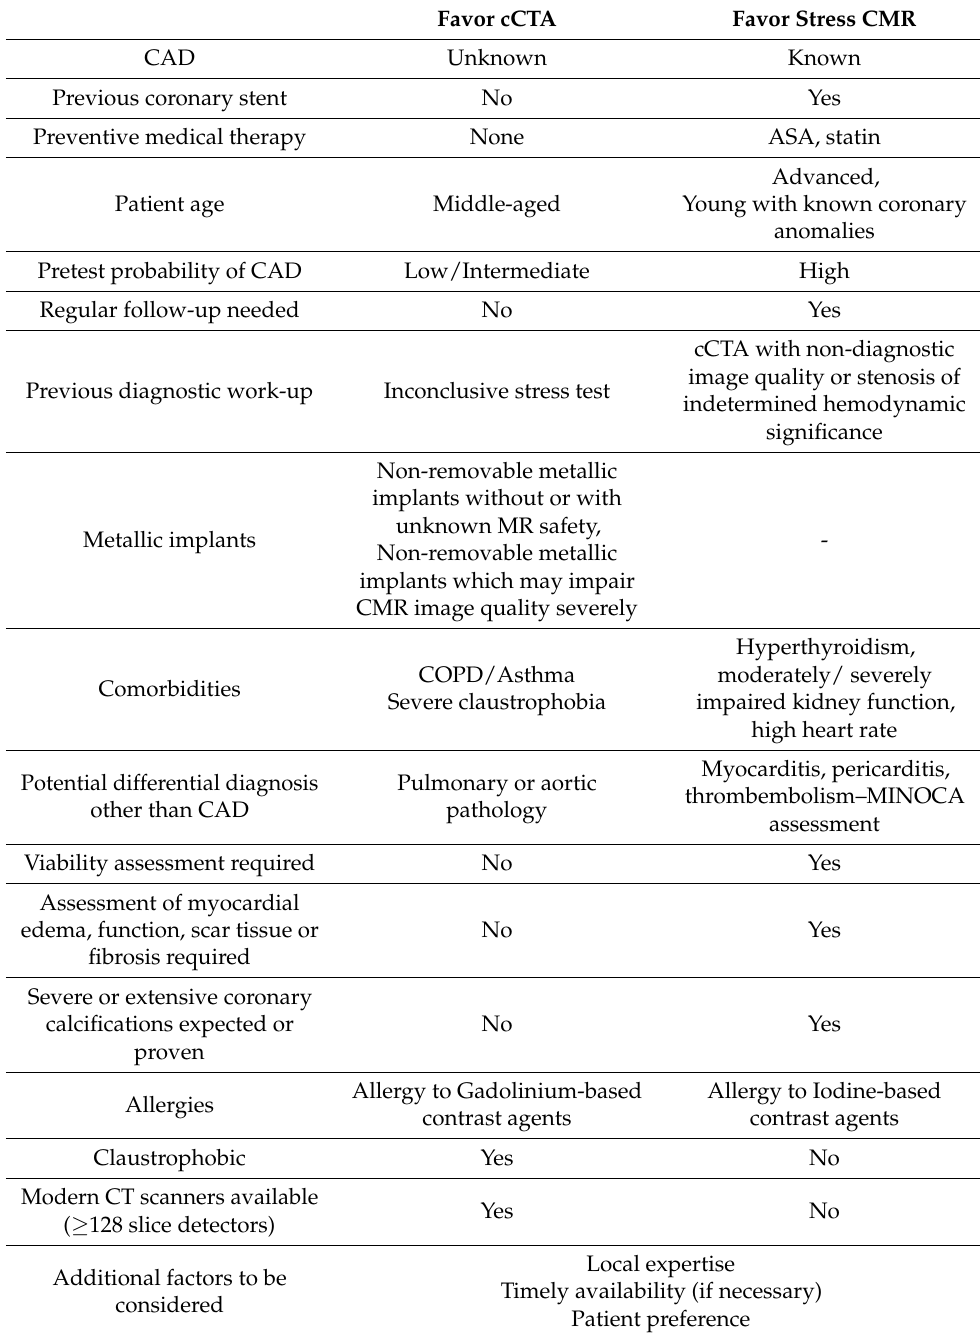
Table 1. Considerable patient factors to select either cCTA or stress CMR as primary diagnostic modality. The combination of the different factors should be taken into consideration to attain the best individual